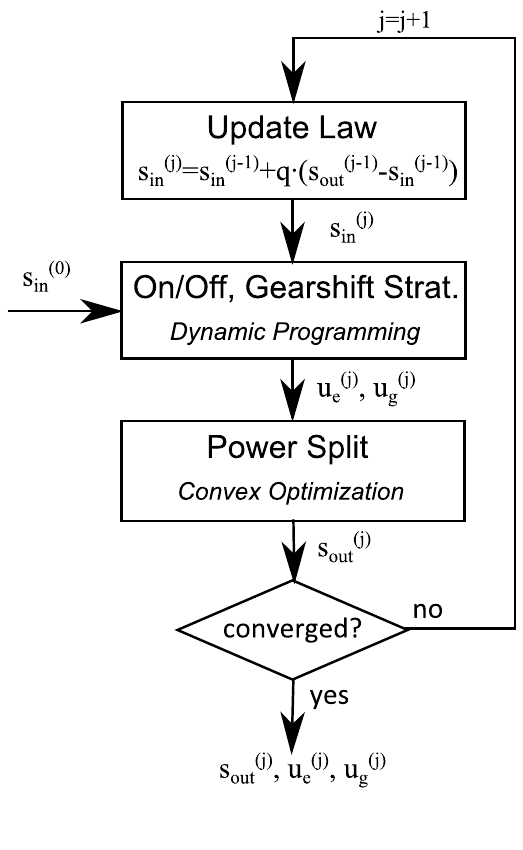
Figure 6. Iteration scheme of the DP-C